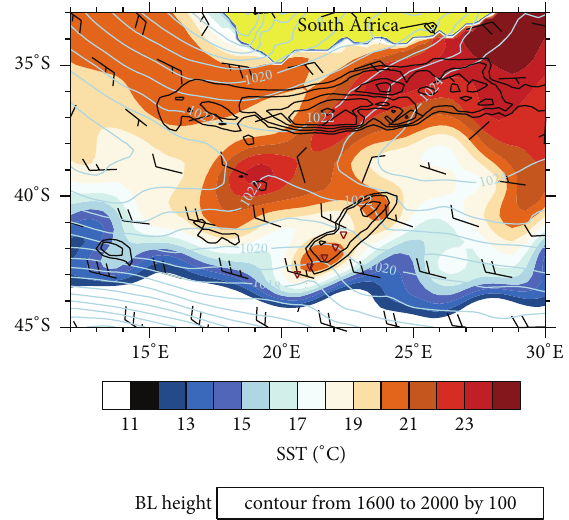
Figure 1: Operational ECMWF archive (forecast with a delayed cutoff) at 09H UTC, 21 March 2008. Wind barbs, pressure field with blue contours, BL height with black contours (from 1800 m to 2000 m height only), and SST as colored background. Triangles represent radiosounding